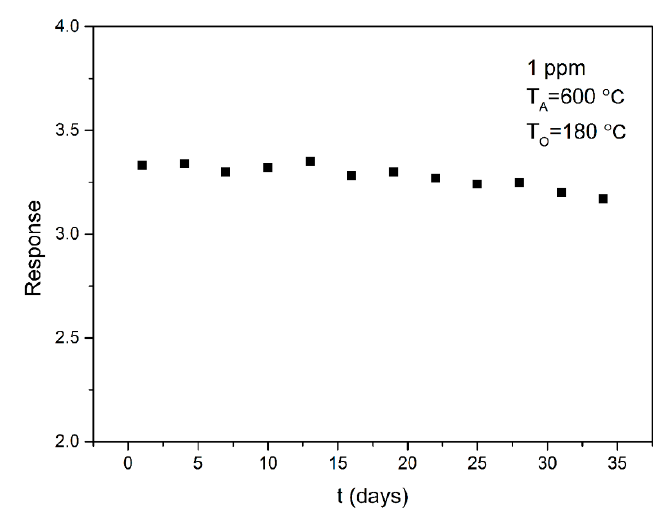
Figure 9. Response stability of SnO 2 thick film sensor measured upon exposure to 1 ppm acetone gas for 33 days.